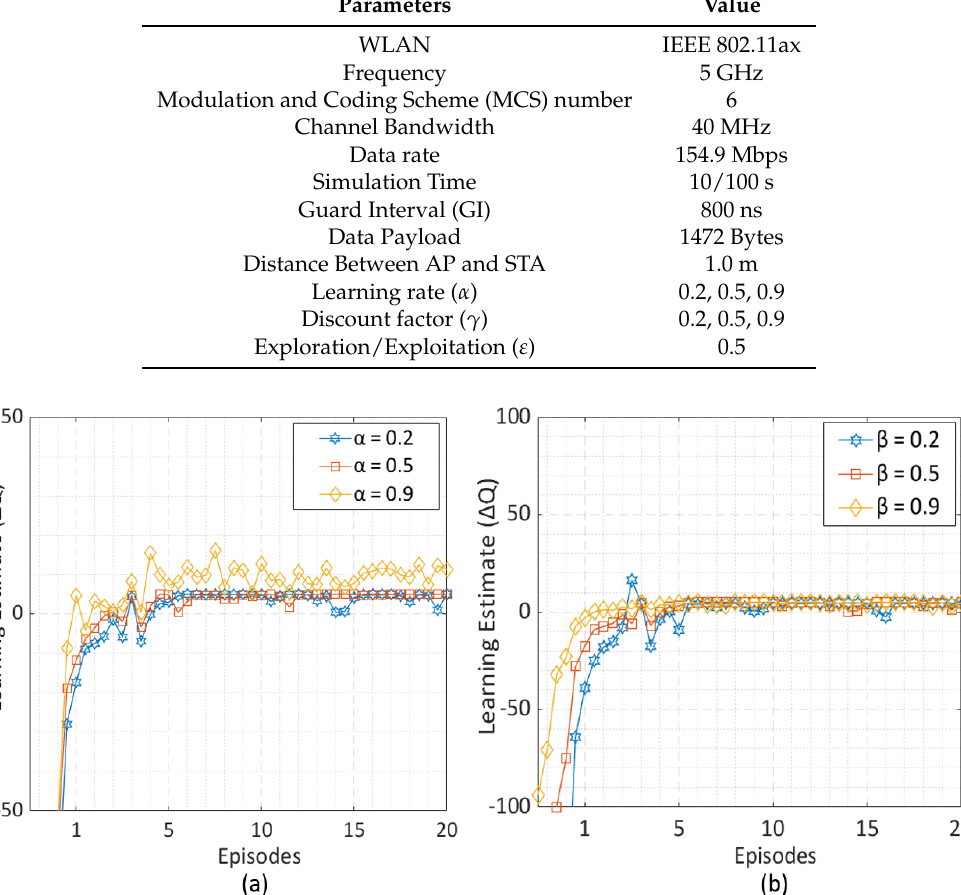
Figure 4. ( a ) Learning estimate ( ∆ Q ) convergence varying value of α ( ε = 0.5)), and ( b ) learning estimate ( ∆ Q ) convergence varying value of γ ( ε =